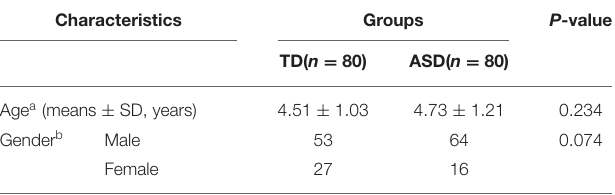
TABLE 1 | Demographic information of ASD group and TD